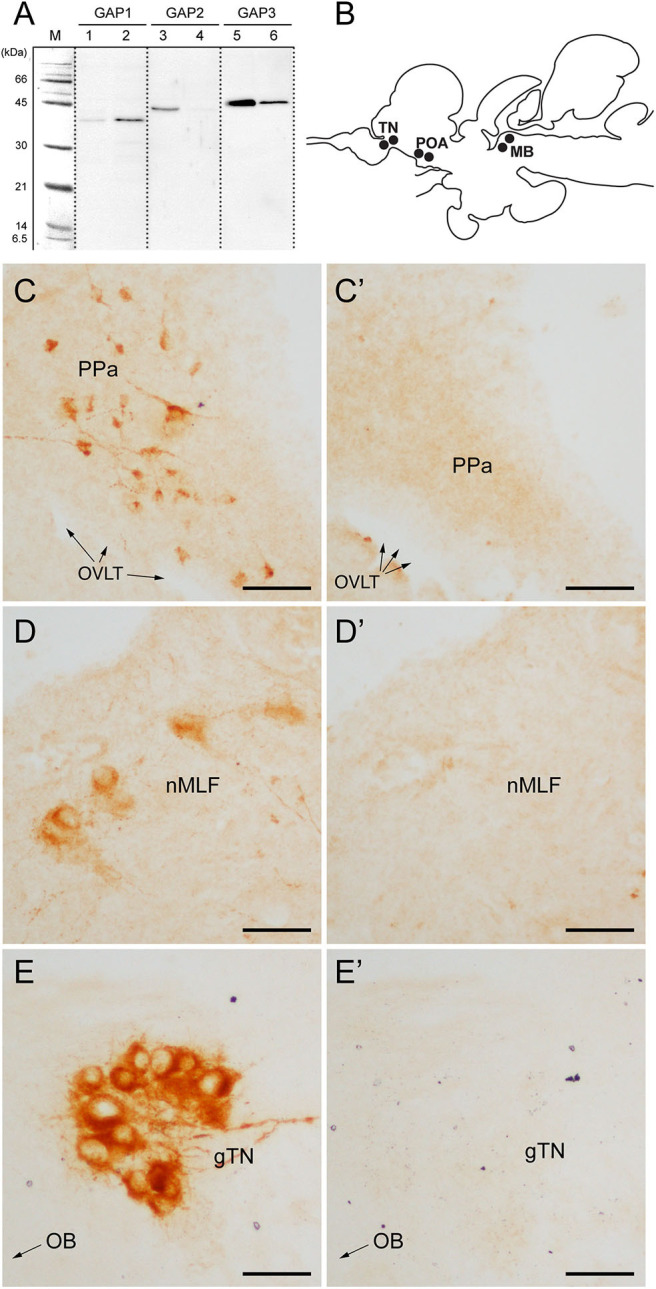
Antibody characterization and immunohistochemical distribution of three GAP-immunoreactivities in the brain of tilapia. (A) Western blot analysis of antisera to GAP types (#ISP105 for GAP1, #ISP205 for GAP2, and #ISP306 for GAP3) in the brain (lanes 1, 3 and 5) and pituitary (lanes 2, 4 and 6) homogenate. M, molecular mass marker. (B) Schematic diagram of distribution of three GnRH-GAP-immunoreactive cell types in the brain of tilapia: GnRH-GAP1 in the preoptic area (POA), GnRH-GAP2 in the midbrain (MB) and GnRH-GAP3 in the terminal nerve (TN). (C–E) Photomicrographs of three GAP-immunoreactivities (C–E) and their preaborption with respective GAP antigen (C'–E'). PPa, anterior part of the parvocellular preoptic nucleus; OVLT, organum vasculosum laminae terminalis; nMFL, nucleus of the medial longitudinal fascicle; gTN, terminal nerve ganglion; OB, olfactory bulb. Scale bars: 50 μm.